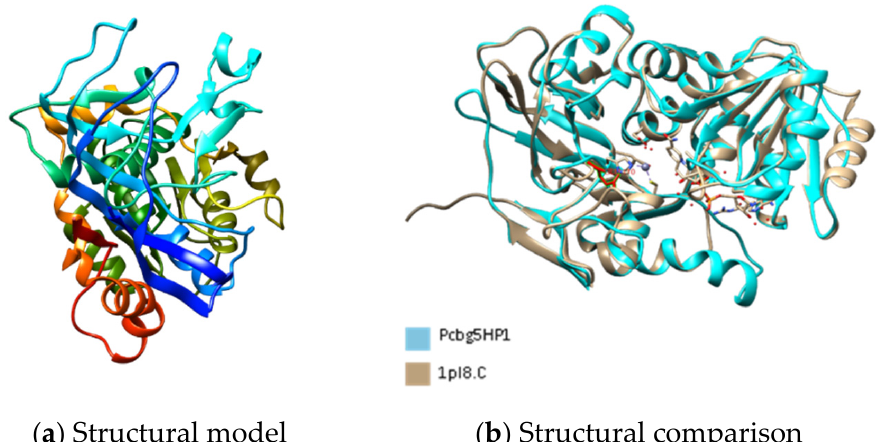
Figure 1. The three-dimensional structure analysis of PCBG5HP1. ( a ) The structural model of PCBG5HP1 was constructed using the Phyre2 server with 24% sequence identity to the structures of 1PL8 as templates [43]. Image coloured by rainbow N → C terminus. ( b ) Comparative structural analysis between PCBG5HP1 model and human sorbitol dehydrogenase/NADH/inhibitor complex (PDB 1PL8).